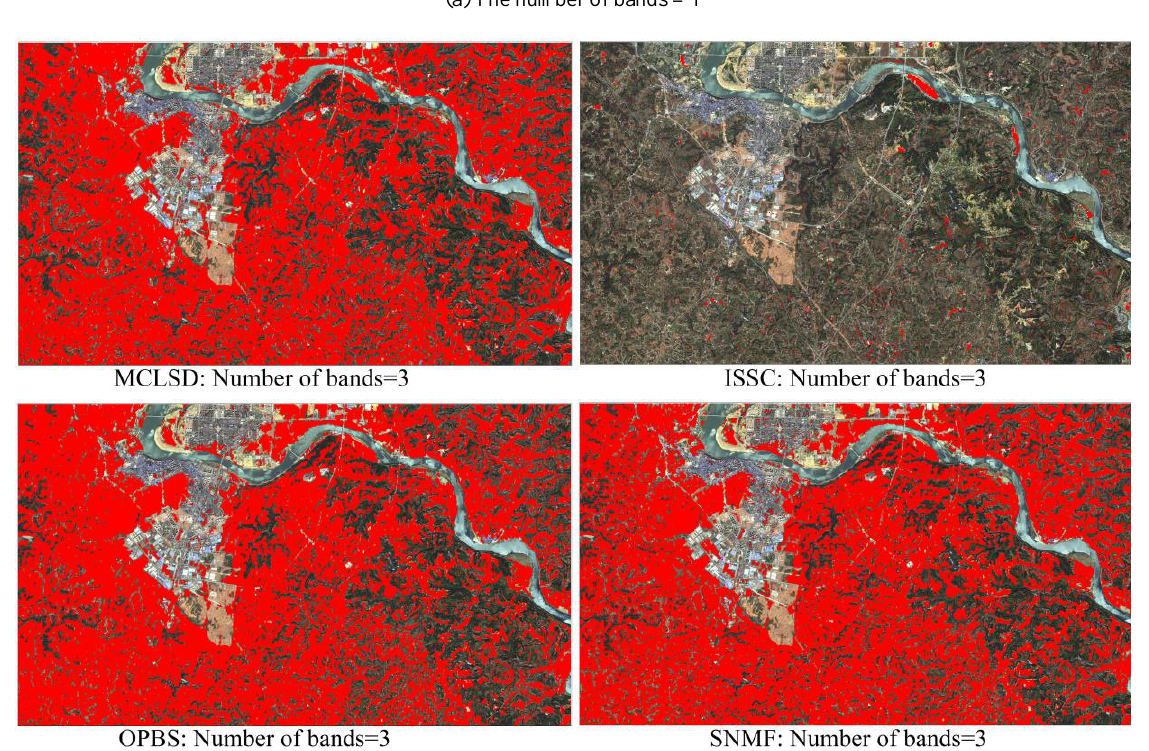
Figure 7. Classification performance of the compared BS